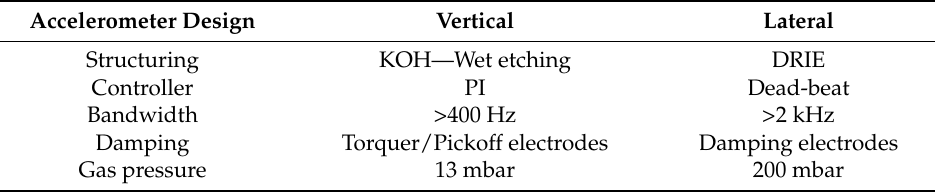
Table 1. Details of two different accelerometer products of NG LITEF with different design